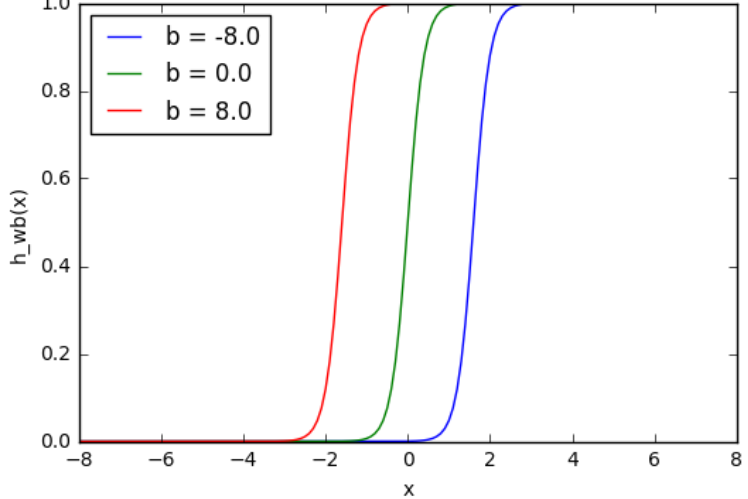
Figure 11. A sigmoid function with displacement.